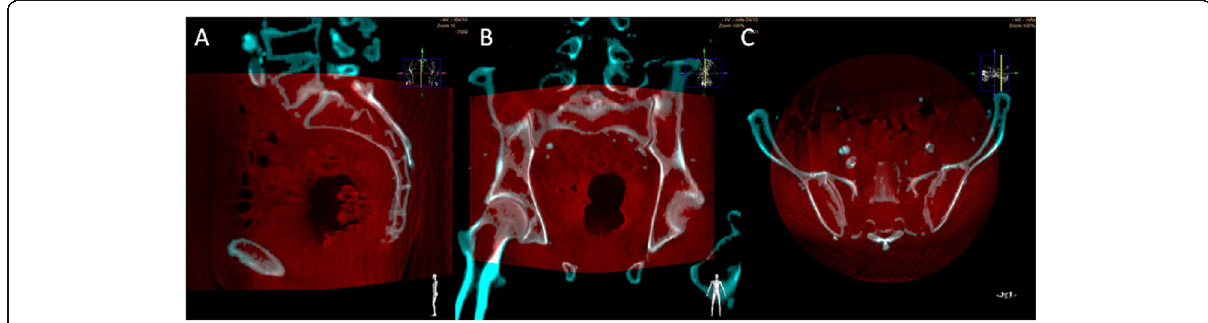
Fig. 1 3D roadmap was created by fusing CT data with virtual vessels and the actual angiography image using the positions of the bones ( a : sagittal planes, b : coronal planes, c : axial planes). Blue zone was from pre procedural CT data. And red zone was the pelvic region with 3D rotational angiography using an angiography machine and reconstructed the acquired volume